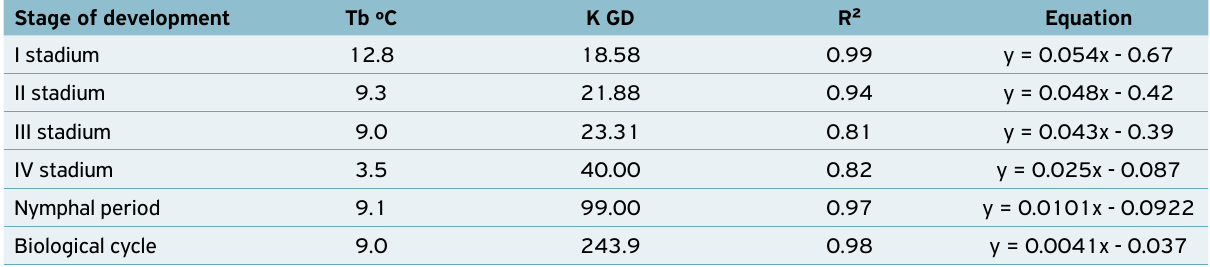
Table 3. Base temperature (Tb), thermal constant (K), determination coefficient and equation of the development rate of Aphis craccivora in cowpeas kept at the constant temperatures of 18, 22, 25, 28 and 32ºC with a photophase of 12 hours. Stage of development